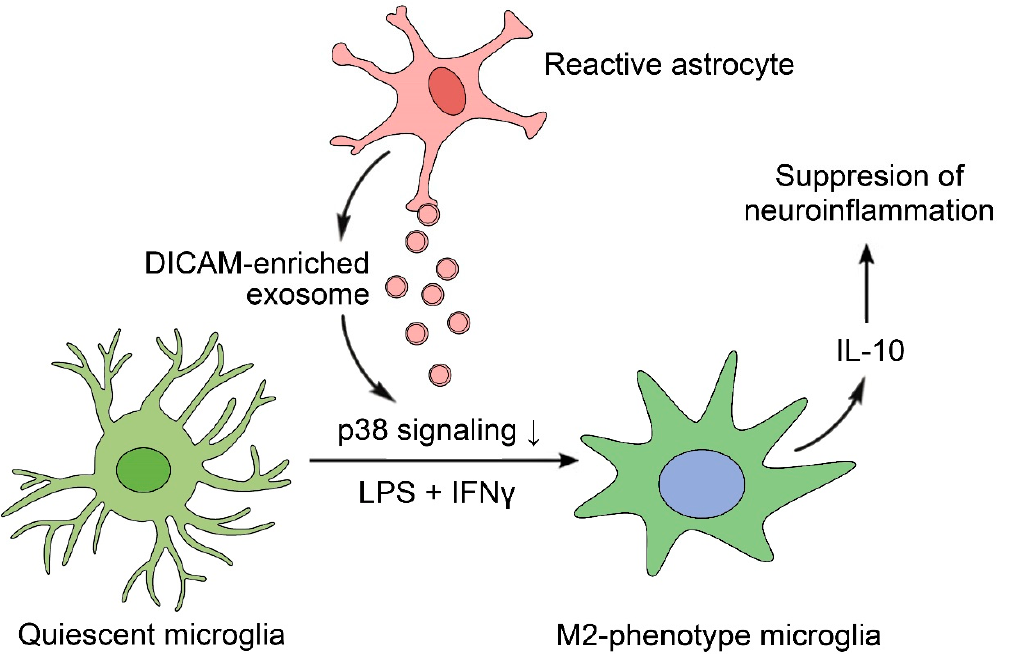
Figure 6. The scheme derived from the present study. Reactive astrocytes secrete DICAM-enriched exosomes in an inflammatory milieu, which polarizes quiescent microglia to anti-inflammatory M2 microglia in the presence of LPS and IFN γ